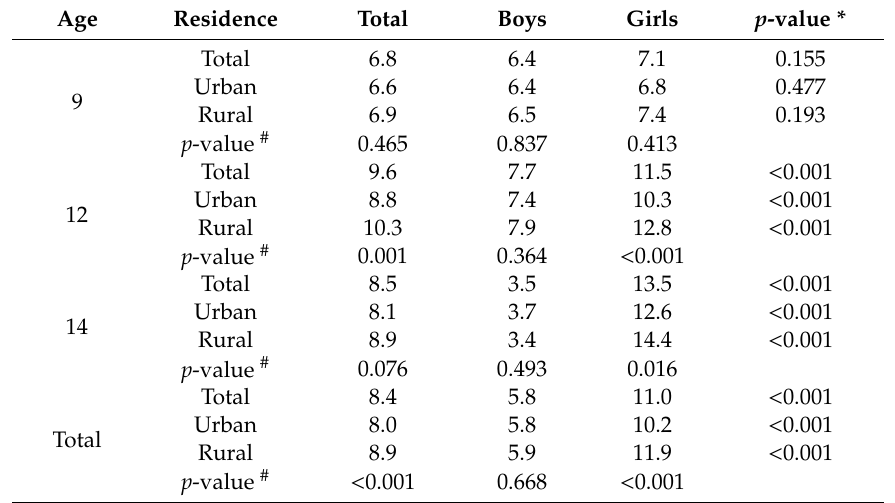
Table 3. Prevalence of anemia in 9-, 12-, and 14-year-old age children, by sex and residence area.